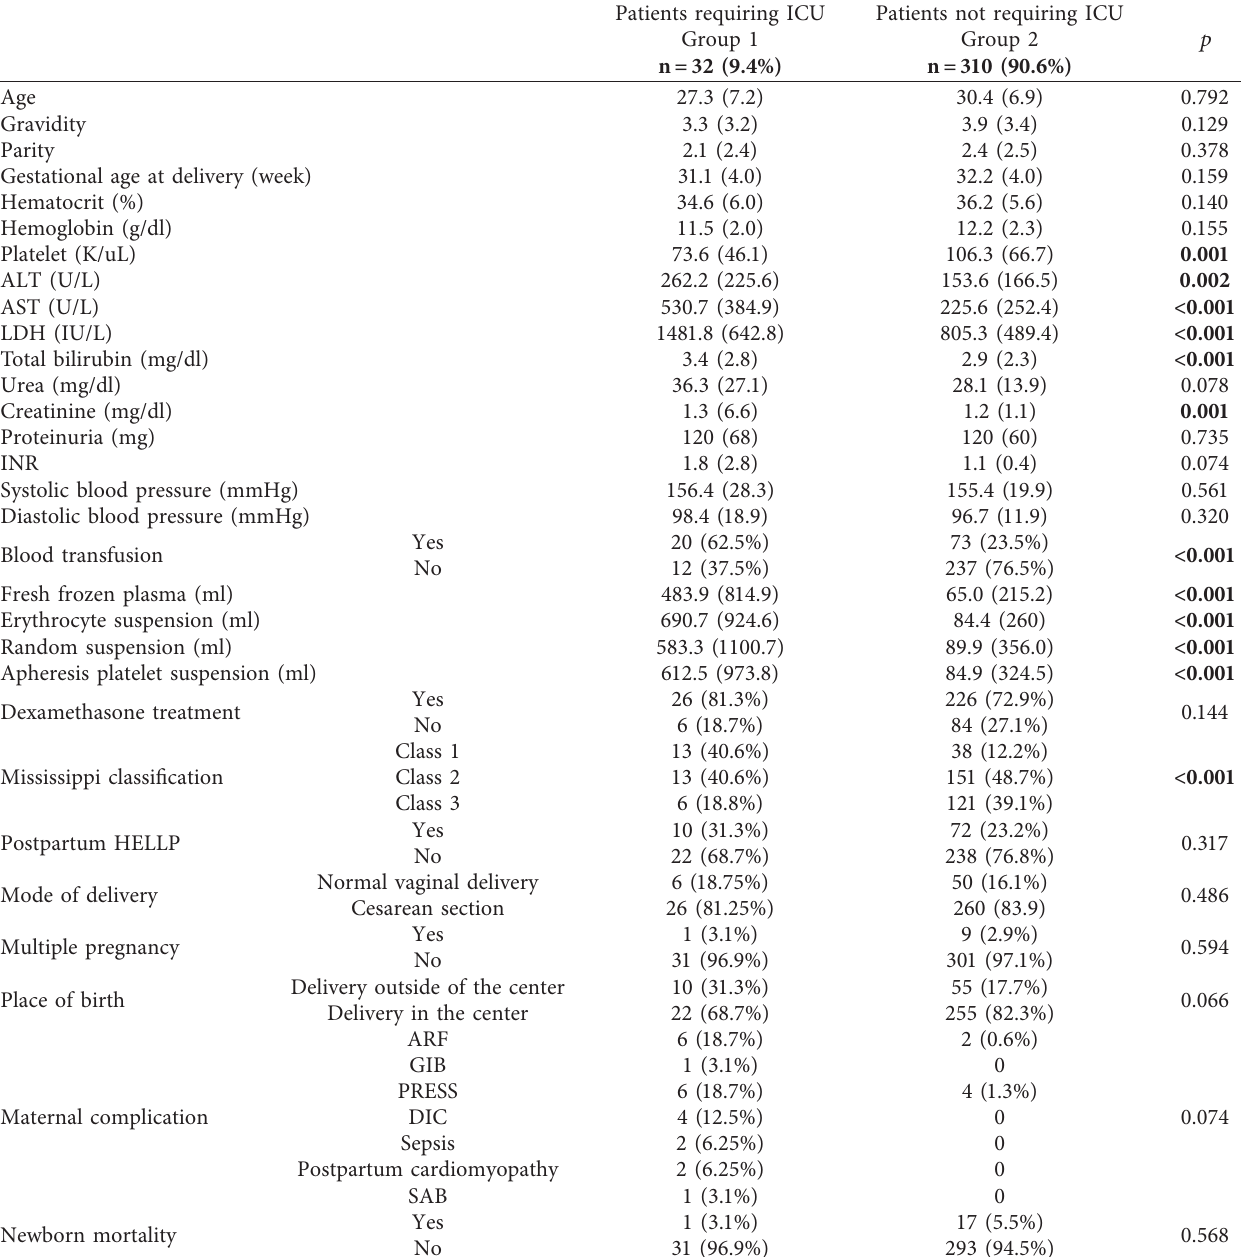
Table 2: Comparison of demographic data in patients staying and not staying in